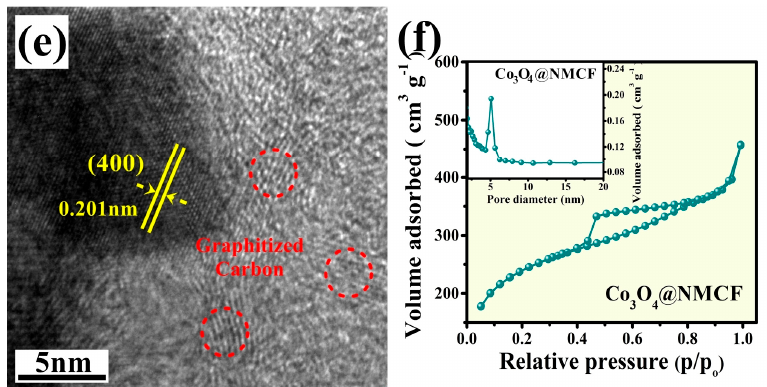
Figure 3. ( a ) SEM image of the polymer hybrid nanofibers; ( b ) SEM, ( c , d ) TEM, ( e ) HRTEM images; ( f ) N 2 adsorption/desorption isotherms and pore-size distribution curves (inset) of the Co 3 O 4 @NMCF composite.